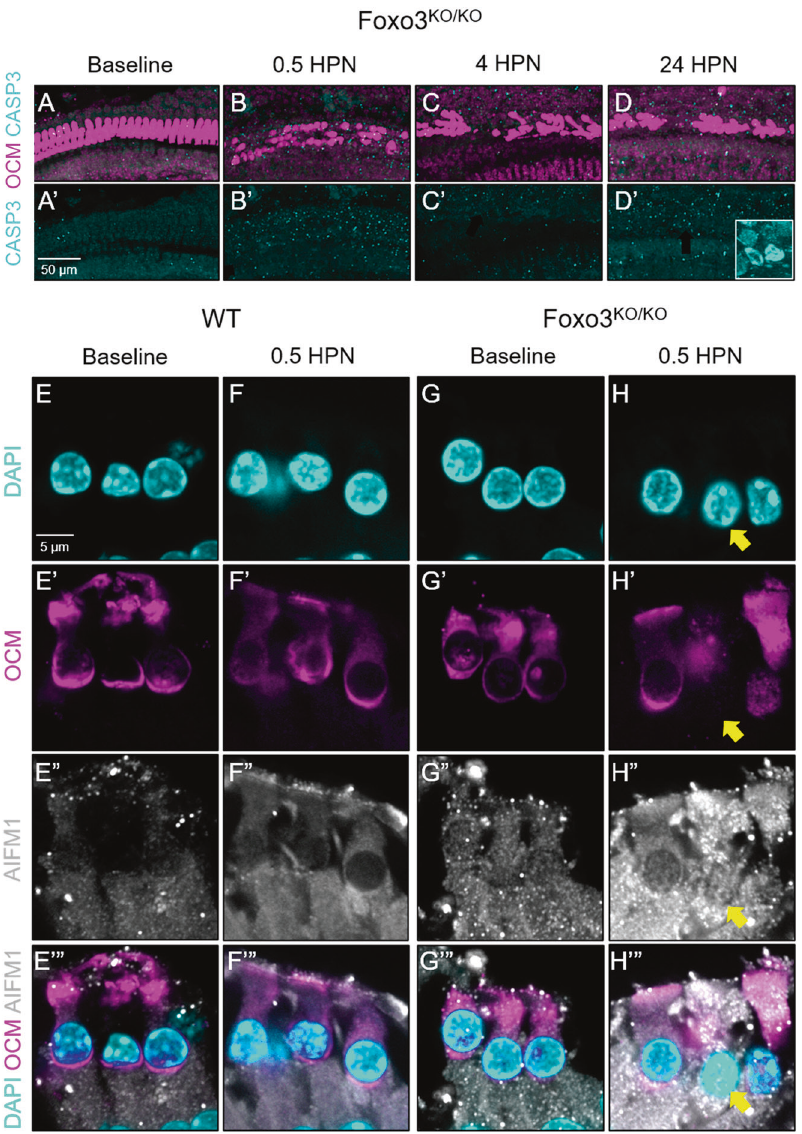
Fig. 3 Foxo3 − / − OHCs do not initiate caspase-dependent apoptosis but may activate parthanatos pathways after mild noise exposure. A – D ′ Multiphoton images of the middle, ~24 kHz region, in whole-mounted cochleae over the established time course. Tissues were analyzed for OCM (magenta) and CASP3 (cyan). D ′ Inset = positive control tissue: CASP3 + apoptotic SGNs after chronic cigarette smoke exposure. n = 3 – 5 per time point, ×20 magni fi cation, scale bar = 50 μ m. E – H ‴ Single-matched optical sections from confocal images of 24 kHz OHCs under baseline conditions and 0.5 HPN. WT ( E – F ‴ ) and Foxo3 − / − ( G – H ‴ ) cochleae were sectioned and immunostained for detection of DAPI (cyan, E – H ), OCM (magenta, E ′ – H ′ ), and AIFM1 (white, E ″ – H ″ ). H – H ‴ The mitochondrial protein AIFM1, localized to the nucleus in the Foxo3 − / − OCM- low OHC (yellow arrow), an indication of parthanatos. n = 4 per genotype/condition, ×200 magni fi cation, scale bar = 5 μ